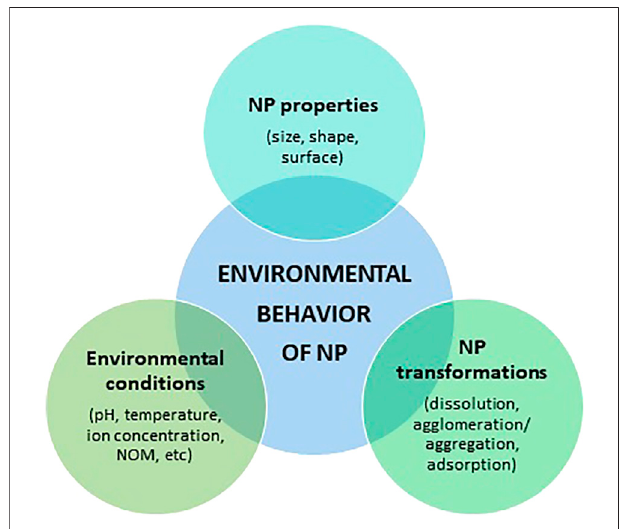
FIGURE 2 | Factors in fl uencing the environmental behavior of